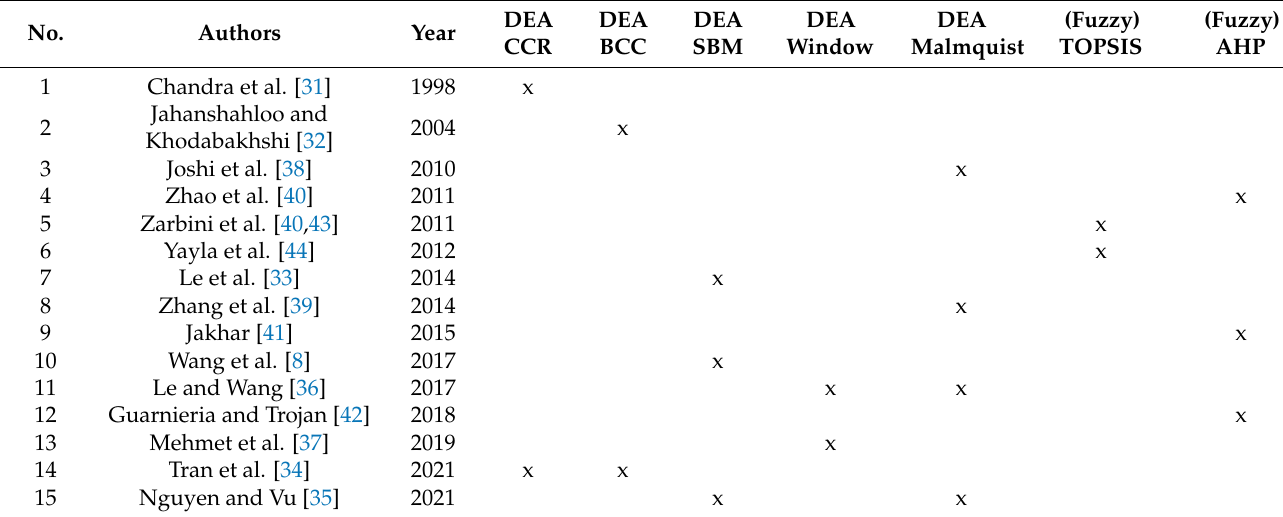
Table 1. List of related methods of previous studies.